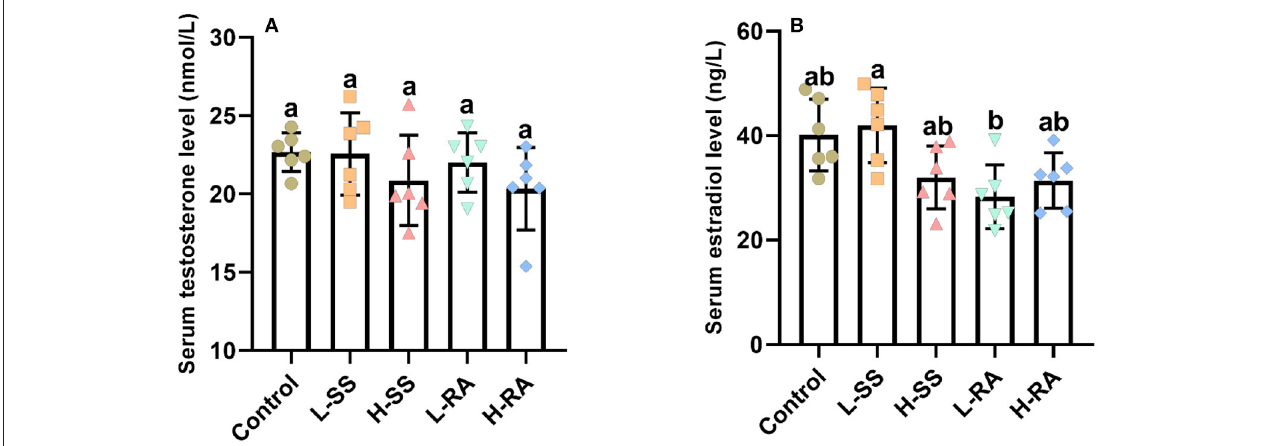
FIGURE 3 | Effect of dietary non-nutritive sweetness drinking on serum concentration of testosterone and estradiol in male guinea pigs. Animals in the control, L-SS, H-SS, L-RA, and H-RA groups were supplied water solution with normal water, 1.5mM sodium saccharin, 7.5mM sodium saccharin, 0.5mM rebaudioside A, and 2.5mM rebaudioside A for 28 days, respectively. Blood samples were collected and centrifuged for the serum to measure testosterone (A) and estradiol (B) concentration by ELISA. Data are shown as means ± SD ( n = 6). Bars with different letters denote significant differences ( P <